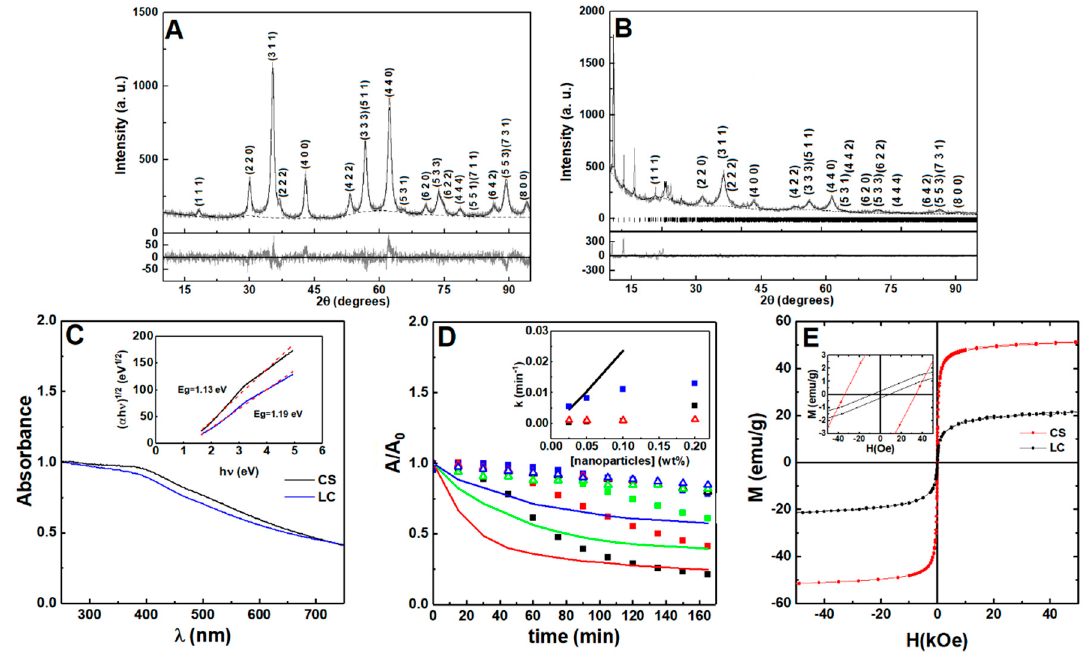
Figure 2. X-ray diffraction pattern of ( A ) citrate-stabilized and ( B ) lipid-coated manganese ferrite nanoparticles. Gray lines: experimental patterns; black lines: fitted patterns; dotted lines: fitted background; the vertical lines in ( B ) are the Bragg diffraction positions of manganese laurate. ( C ) Absorption spectra of citrate-stabilized (CS, black line) and lipid-coated (LC, blue line) MnFe 2 O 4 nanoparticles. Inset: Tauc plot of citrate-stabilized and lipid-coated nanoparticles. ( D ) Sedimentation profiles of the citrate-stabilized (squares), lipid-coated (triangles), and bare (line) MnFe 2 O 4 nanoparticles at 0.2 wt% (black), 0.1 wt% (red), 0.05 wt% (green), and 0.025 wt% (blue). Inset: sedimentation rate dependence on nanoparticle concentration. The citrate-stabilized aggregation rate is included (black squares). ( E ) Magnetization hysteresis loops of citrate-stabilized and lipid-coated manganese ferrite nanoparticles measured at room temperature (T = 300 K). Inset: Enlargement of the loops in the low field region.